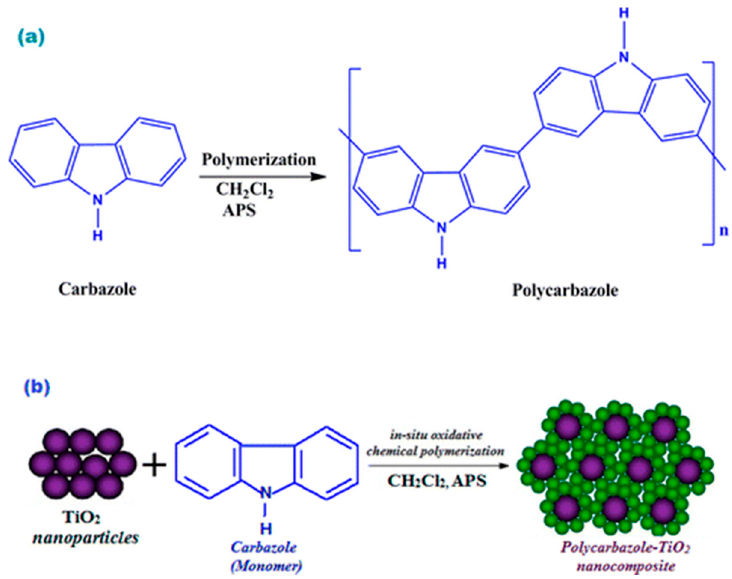
Figure 5. Schematic Diagram of the Formation Mechanism of ( a ) PCz and ( b ) PCz/TiO 2 Nanocomposite. Reprinted with permission from Shakir et al. [100]. Copyright (2014) American Chemical Society.